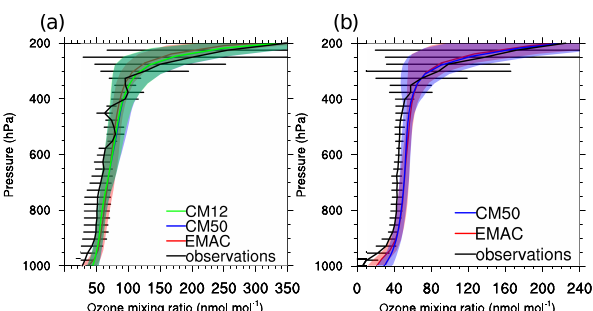
Figure 14. Vertical profile showing the RMSE of the model data compared to the ozone sonde data (in nmolmol − 1 ) for (a) June and (b) December